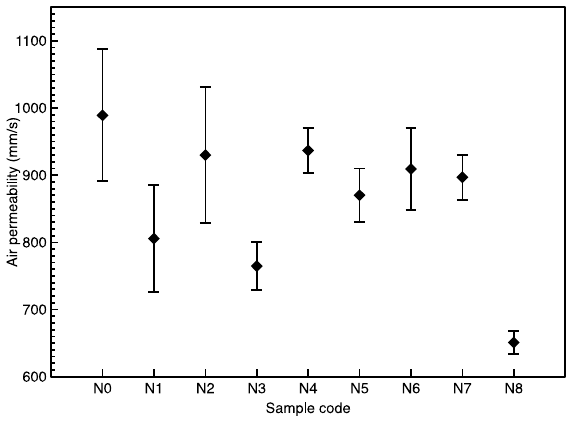
Figure 7. Air permeability of Cu/Ni-coated Milife fabric.